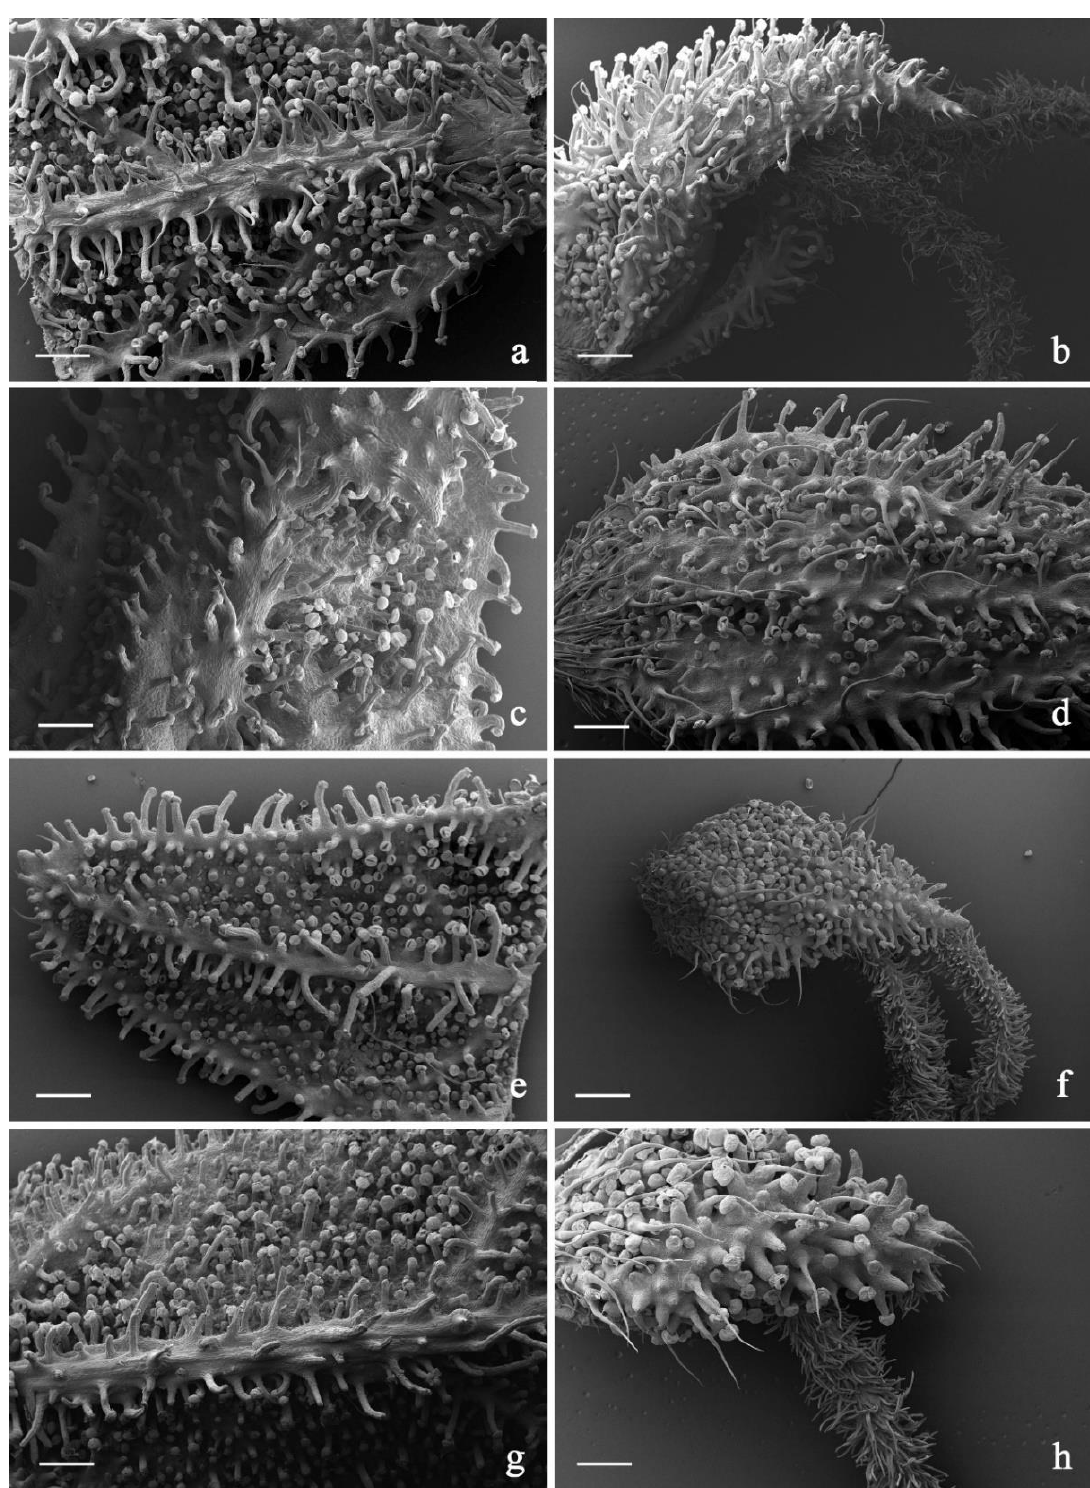
Figure 9. SEM micrographs showing the trichome distribution pattern on bracts and bracteoles of the investigated C. sativa varieties. ( a , b ) Pablito hemp variety: abaxial surfaces of bract ( a ) and bracteole ( b ); ( c , d ) White Shark hemp variety: abaxial surfaces of bract ( c ) and bracteole ( d ); ( e , f ) Venom OG hemp variety: abaxial surfaces of bract ( e ) and bracteole ( f ); ( g , h ) Lemon Conti Kush New hemp variety: abaxial surfaces of bract ( g ) and bracteole ( h ). Scale bars = 500 µ m ( a – g ); 200 µ m ( h )